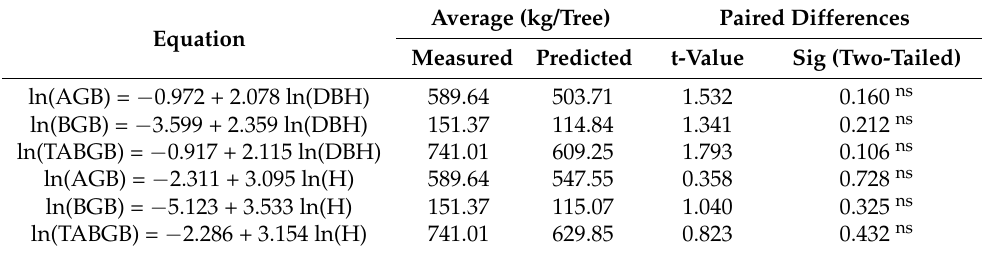
Table 7. Paired t -test differences between the measured and the predicted of the 10 independent validation data.